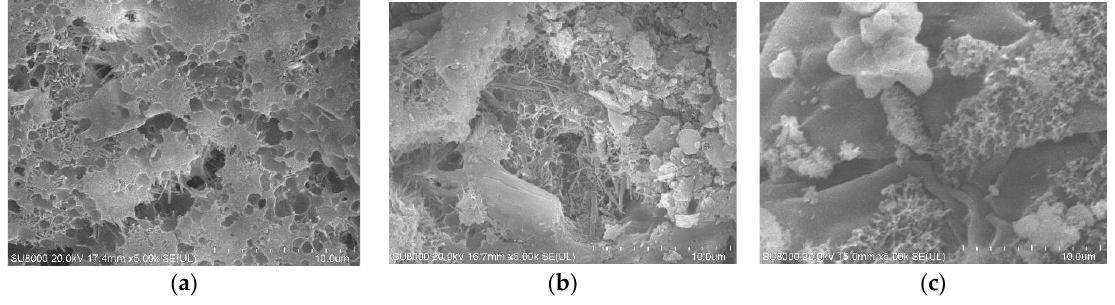
Figure 11. The SEM morphology photograph of lightweight CLSM. ( a ) Group 4; ( b ) Group 6; ( c ) Group 9. ( c ) Group 9.